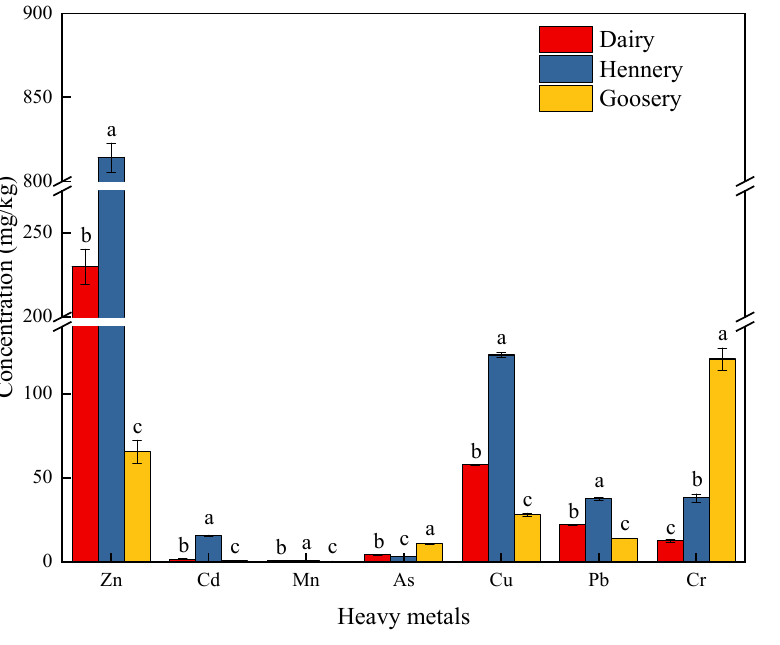
Figure 3. Concentrations of heavy metals in biogas residues from three types of farms. Different letters indicate significant differences between different types of farms ( p < 0.05).